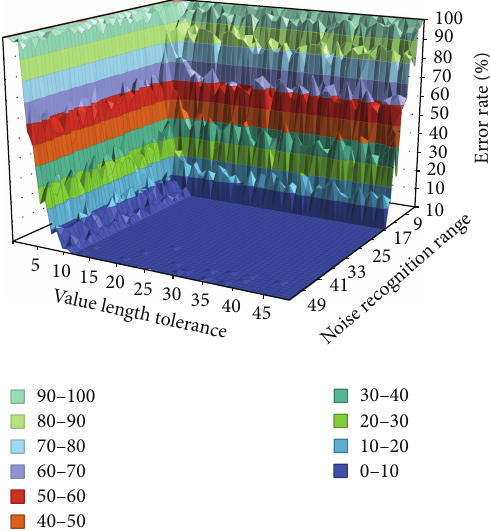
Figure 10: FAR and FRR performance of Key 2.